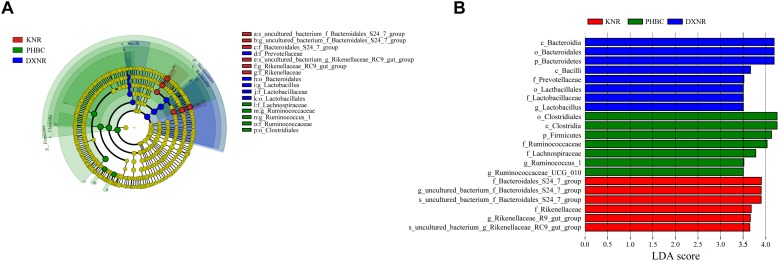
LefSe analysis. (A) Cladogram based on LefSe analysis showing the OTUs with significant differences between the three study sites. Taxonomic hierarchies were arranged from the inside (lower taxonomic level) to the outside (higher taxonomic level). Red, green, and blue nodes in the phylogenetic tree represent differentially abundant OTUs at the three study sites (KNR, PHBC, and DXNR, respectively). Yellow nodes represent OTUs with no significant difference. (B) OTUs with significant difference that have an LDA score > the threshold value of 3.5; letters in front of OTUs represent taxonomic level (p = phylum, c = class, o = order, f = family and g = genus).